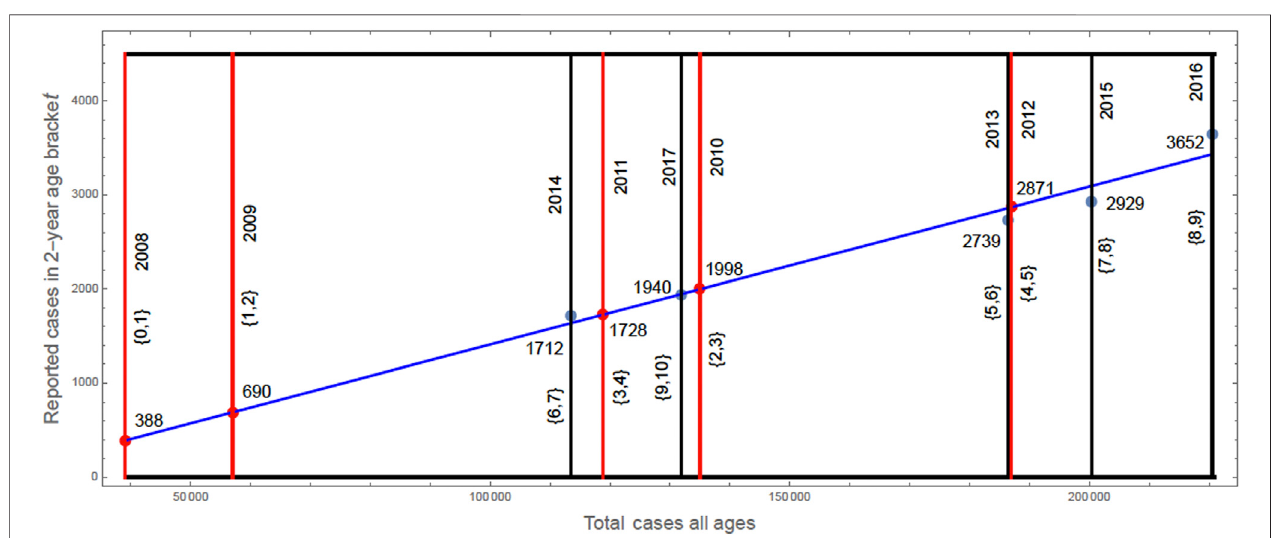
FIGURE 3 | The graph of F ( y ), where y (cid:2) 187,031 for 2012, y (cid:2) 1,188,681 for 2011, y (cid:2) 135,000 for 2010, y (cid:2) 57,000 for 2009 [8], and y (cid:2) 39,000 for 2008 [6].